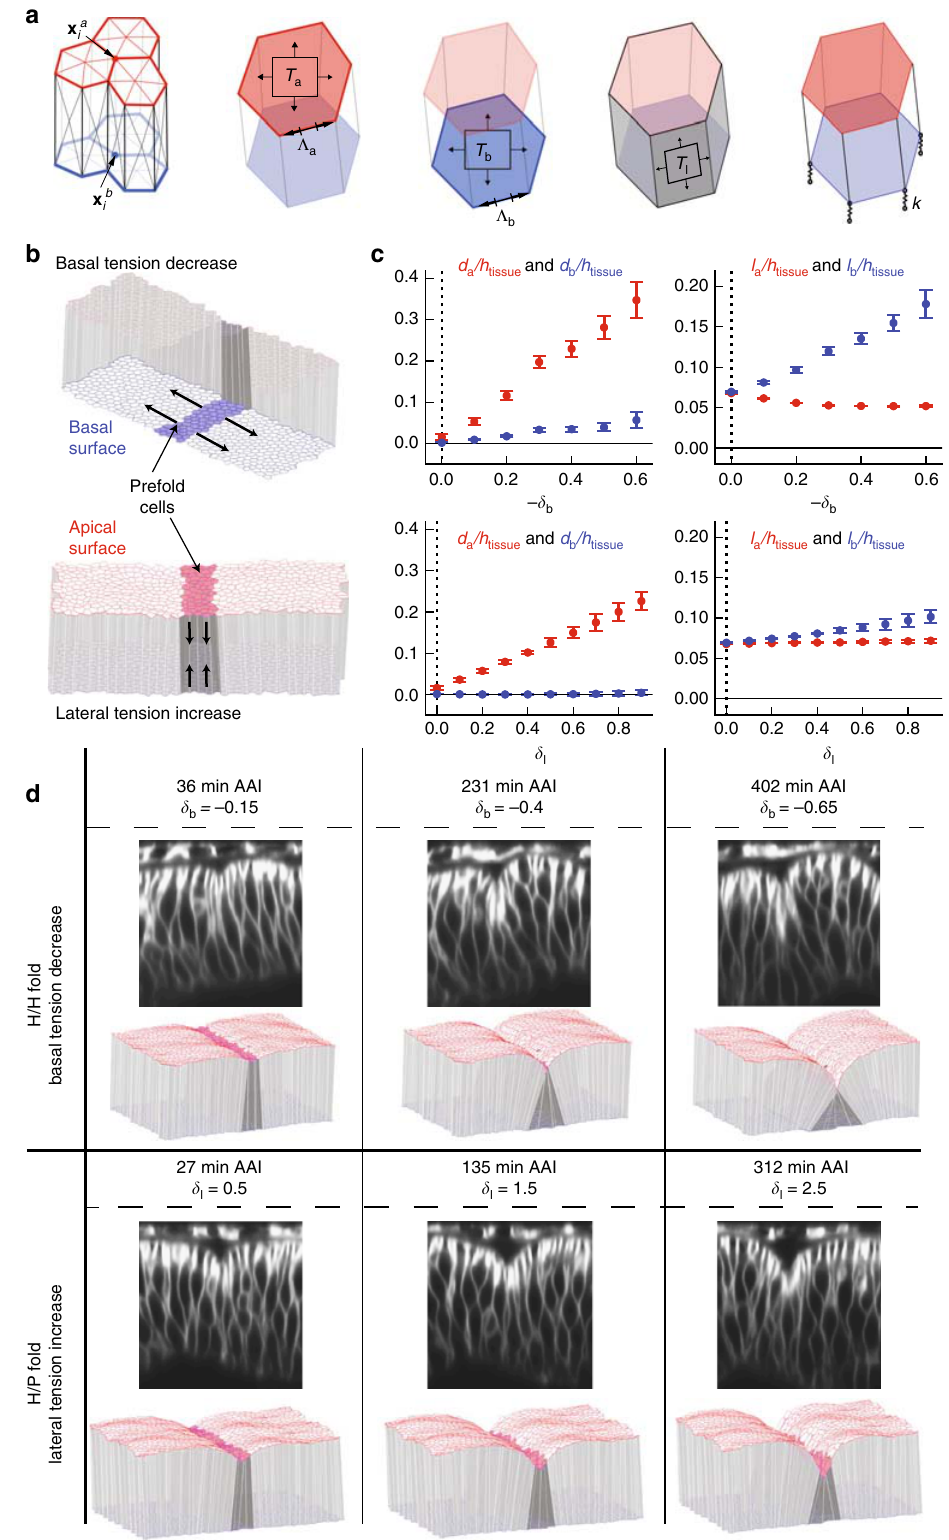
of tension may therefore represent two important mechanisms driving the folding of epithelia in different